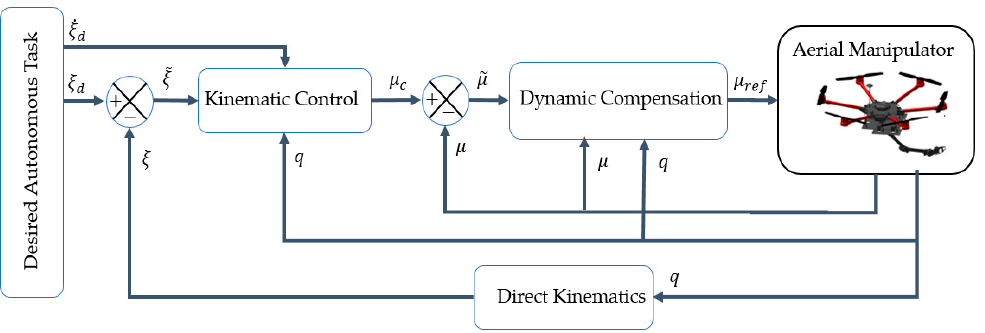
Figure 2. Proposed controller scheme.